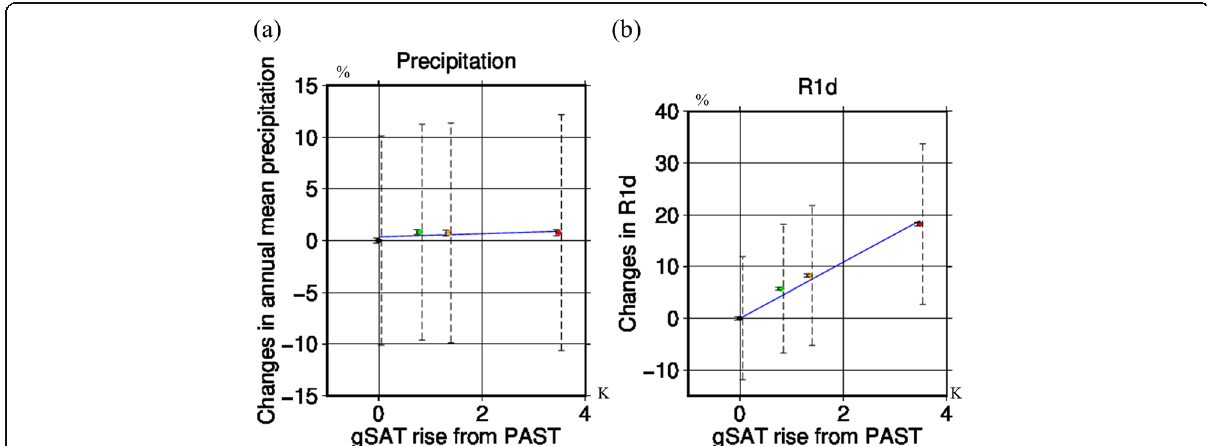
Fig. 9 Changes in annual mean precipitation and R1d. Changes in a annual mean precipitation relative to the gSAT increases and in b R1d relative to the gSAT increases. Values are averaged on all land grids on the Japanese Islands. The solid bars indicate standard errors of the ensemble mean, and the dashed bars indicate standard deviations. The blue color denotes linear fitting. The black circle, green circle, yellow circle, and red circle indicate PAST, d1.5, d2, and d4, respectively